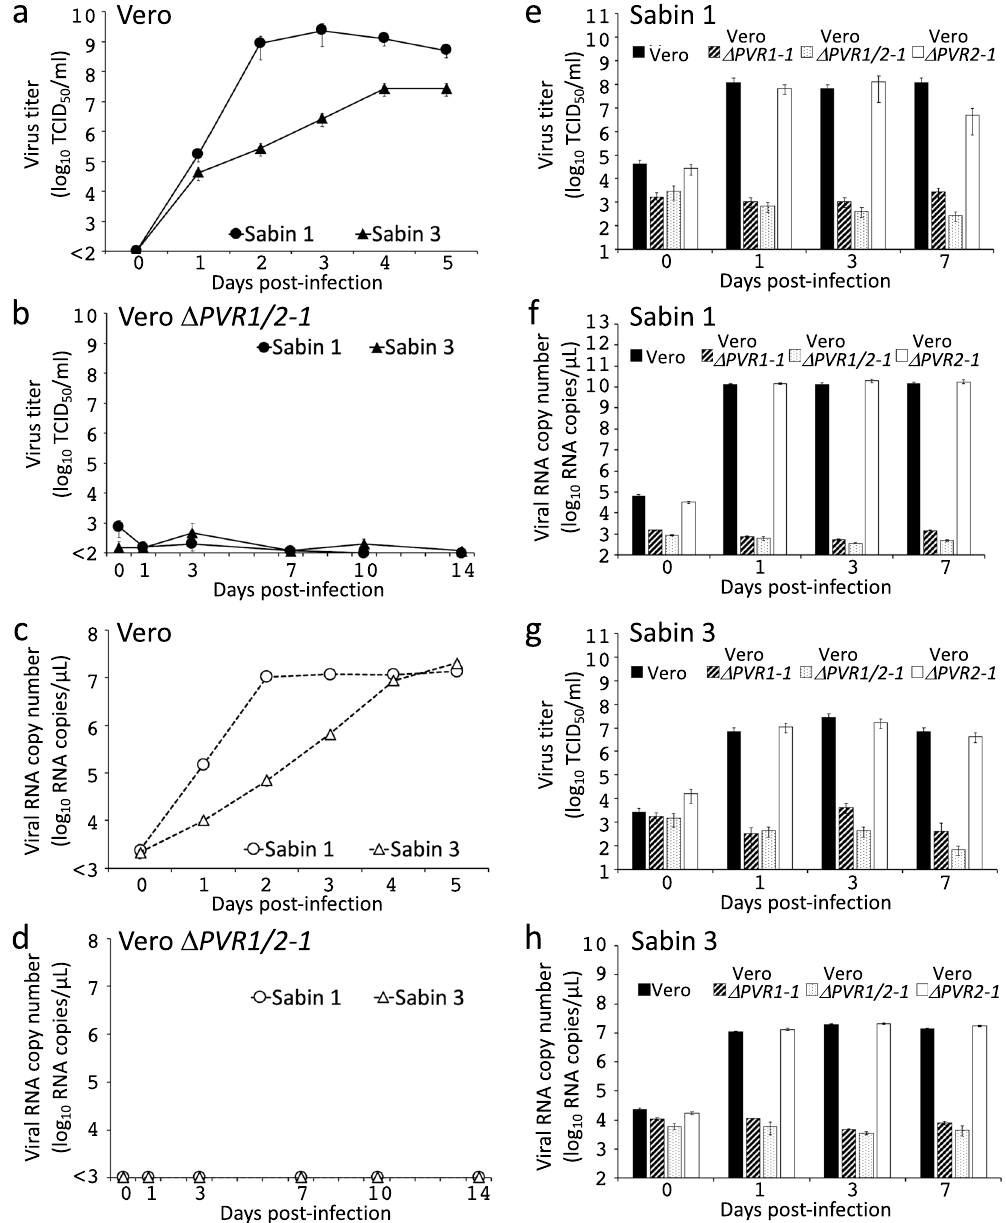
Figure 4. PV replication and viral RNA synthesis in the parental and PVR -disrupted Vero cell lines. ( a – d ) The indicated cell lines were infected with PV Sabin 1 and 3 strains at MOI of 0.01 ( a – d ) and 10 ( e – h ), and virus titers ( a,b,e,g ) and viral RNA ( c,d,f,h ) in the culture fluids were quantified at the indicated times post-infection (mean ± standard deviation, n = 3). See also Supplementary Fig. 3 for other Vero PVR -disrupted cell clones established in this